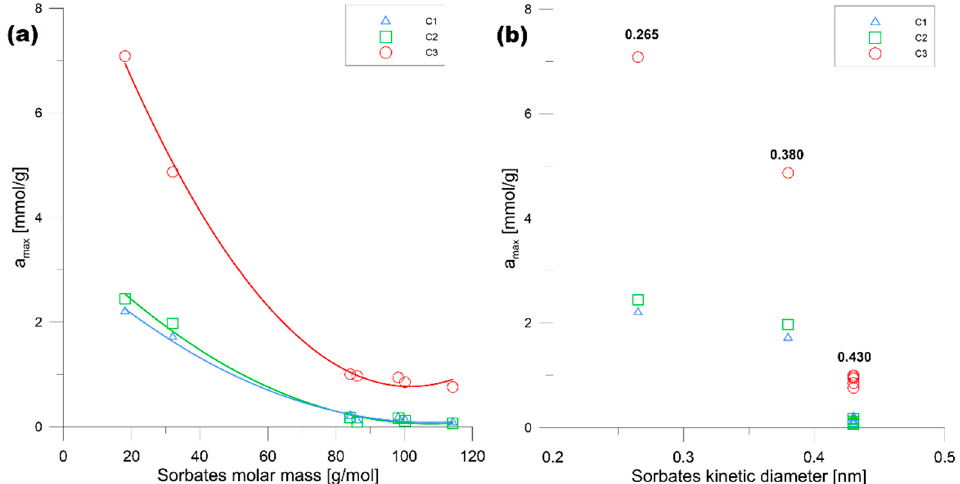
Figure 7. Maximum values of sorption a max of water vapour, methanol vapour, n-hexane, 1-hexene, n-heptane, 1-heptene, and n-octane on coals C1, C2, C3: ( a ) in relation to molar mass of sorbates and ( b ) in relation to kinetic diameter of sorbates.